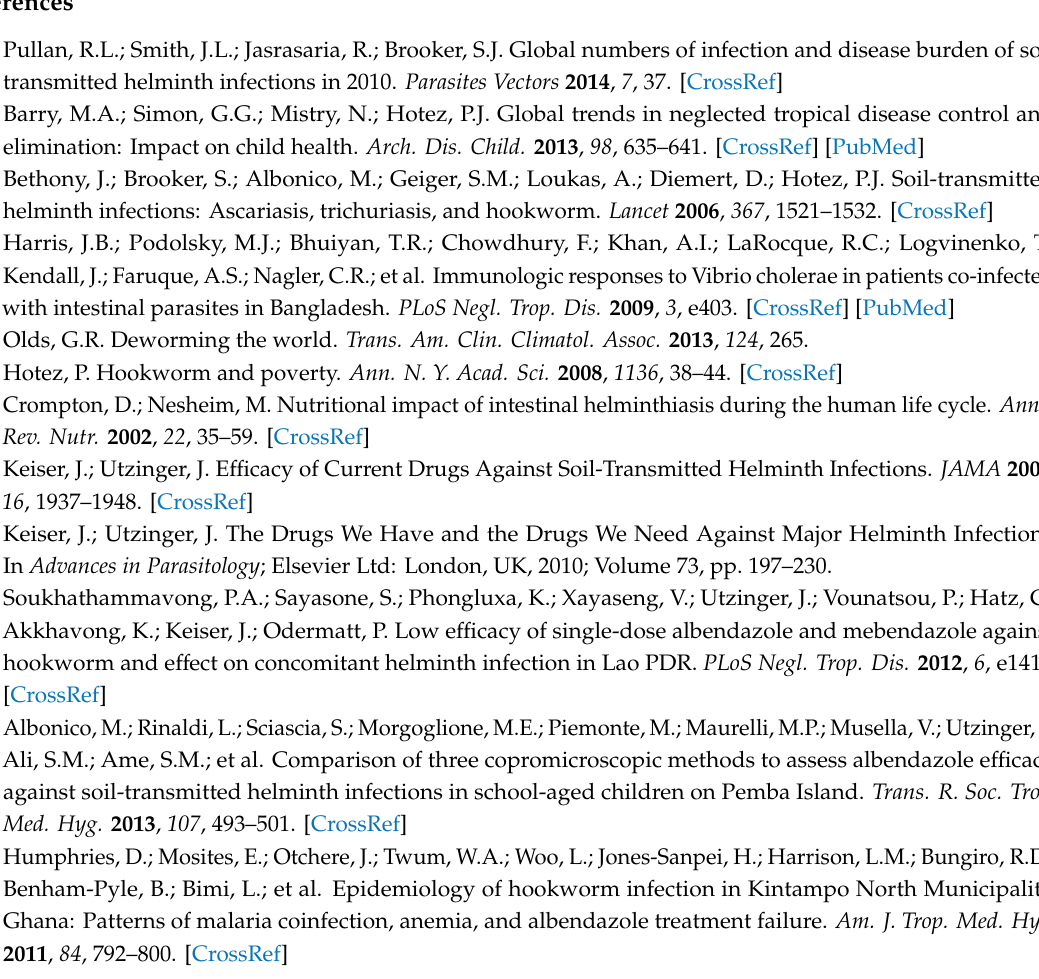
Supplementary Materials: The following are available online, Figure S1: Chemical structure of terpenes, Table S1: Octanol / water partition coe ffi cient (log P), solubility in water, and HPLC retention time with isocratic method (acetonitrile:water 70:30) of terpenes evaluated for encapsulation in YPs, Table S2: Terpene loading of selected YP–terpene